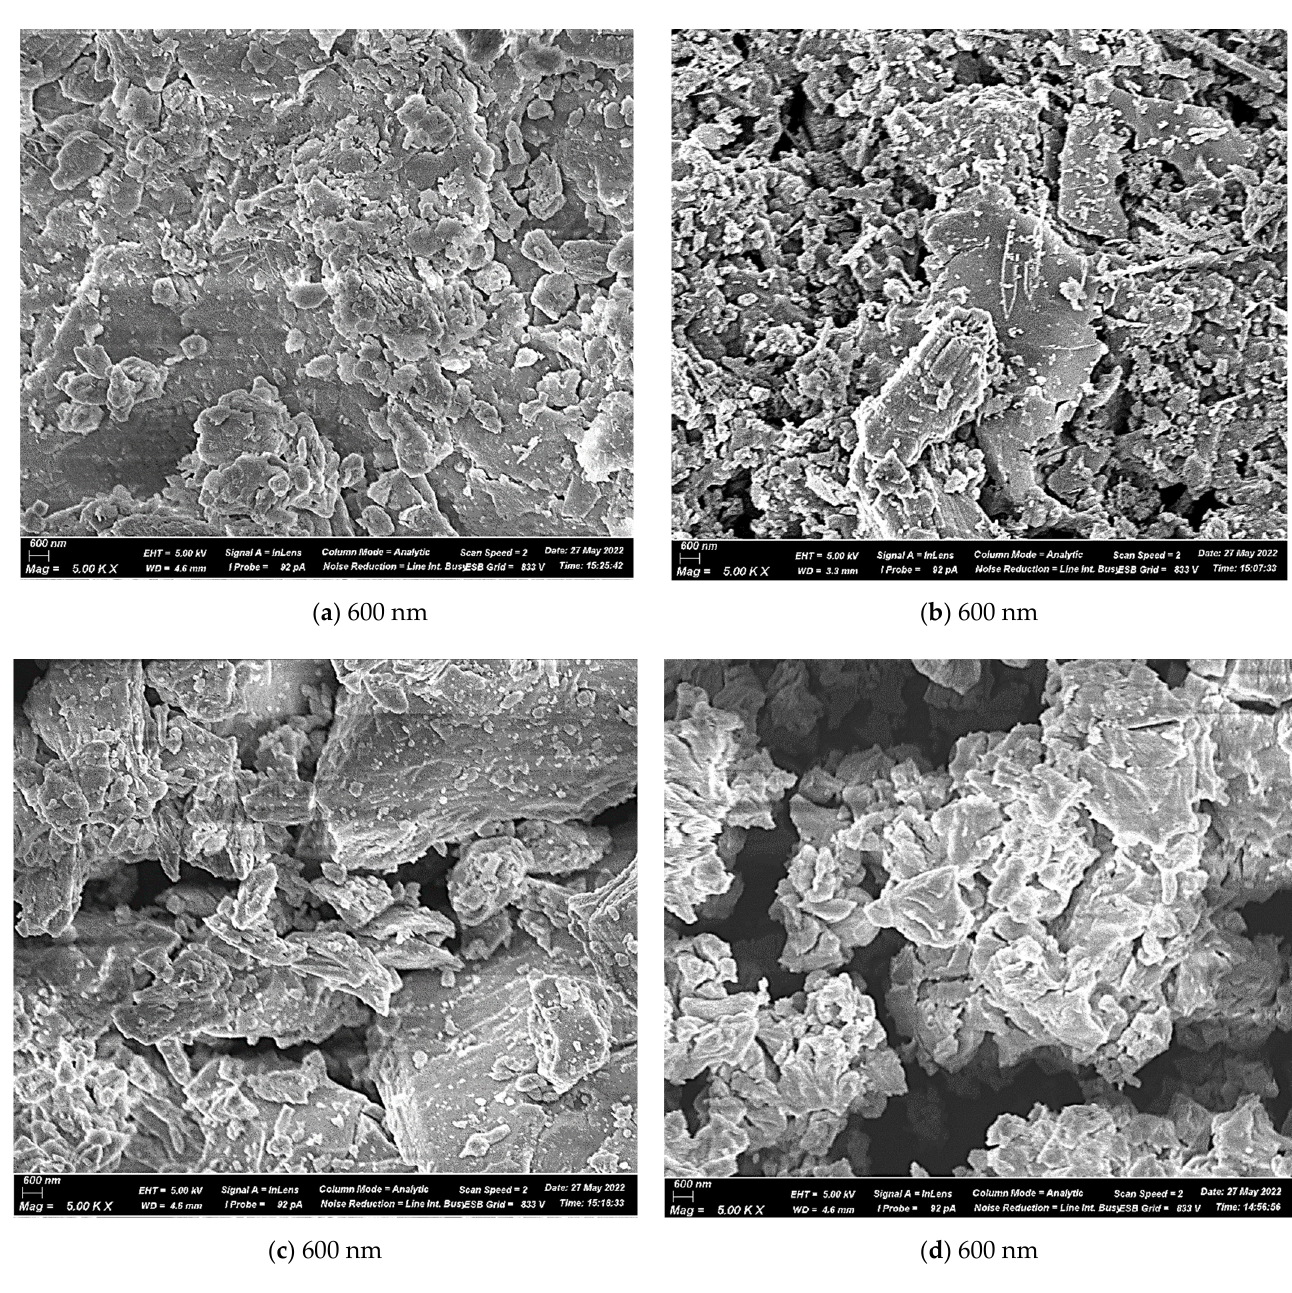
Figure 3. The SEM images of the ( a ) NL, ( b ) RM, ( c ) BFS, ( d ) LPW.